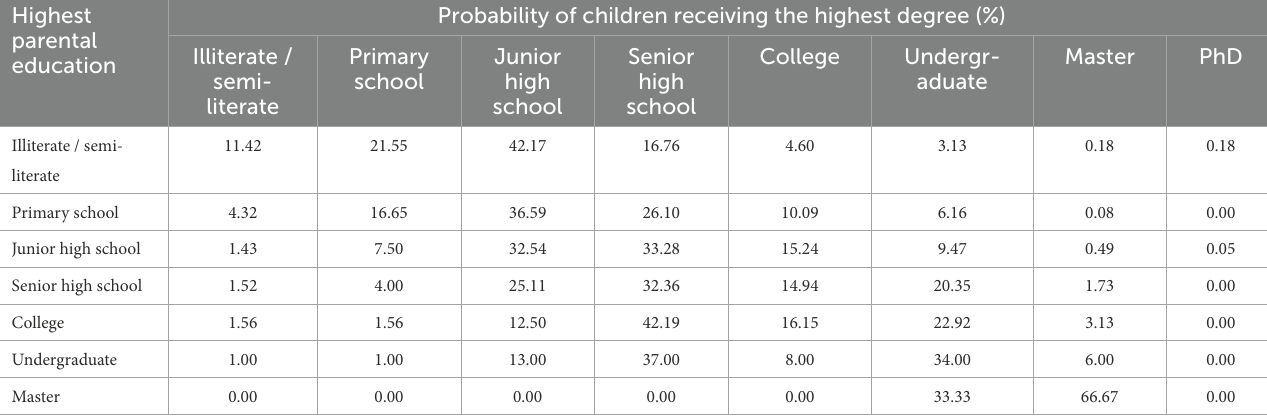
TABLE 2 Education intergenerational transmission transition matrix.